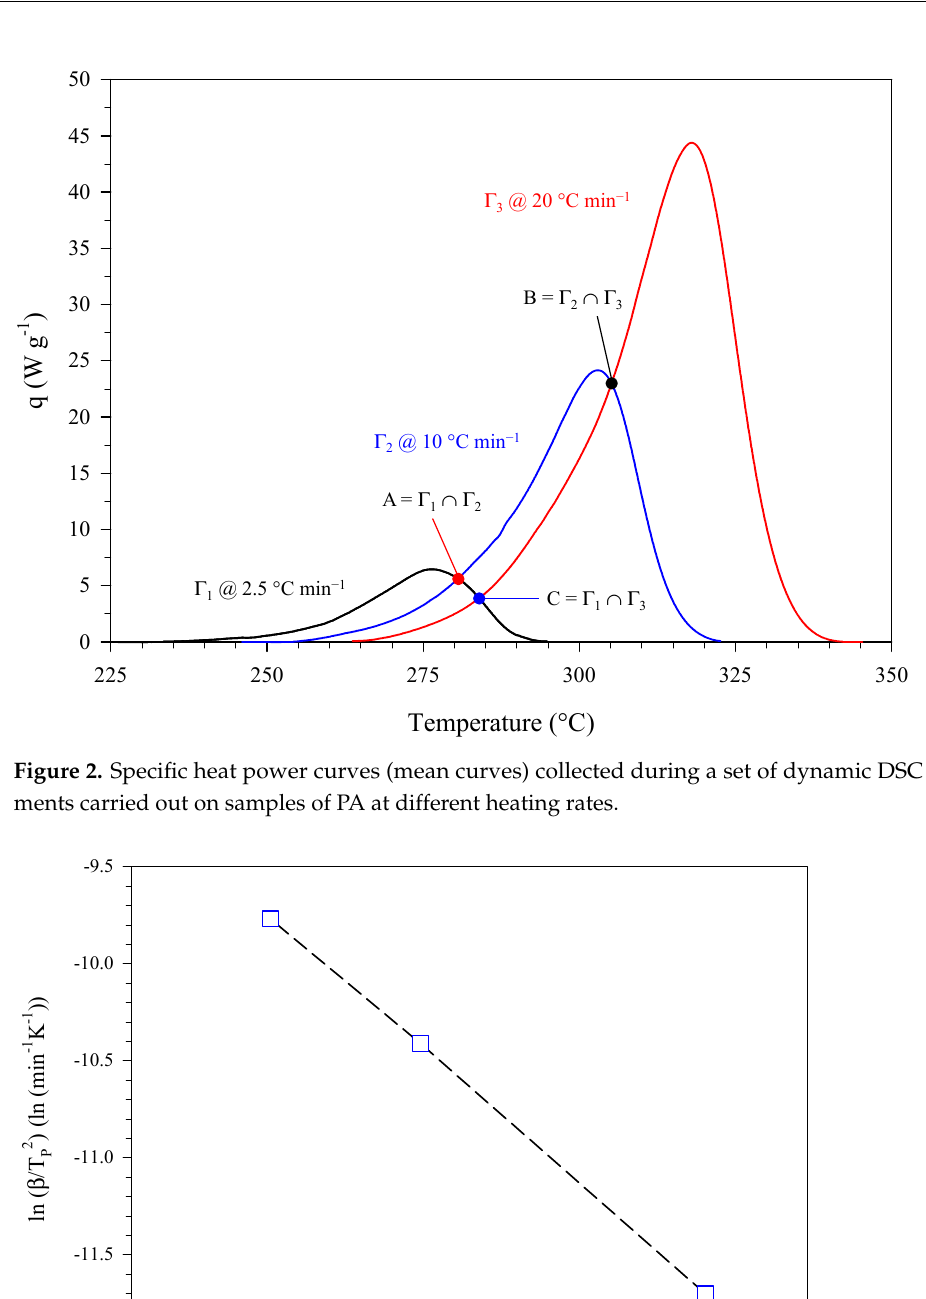
Figure 3. Kissinger plot corresponding to the curves of Figure 2.